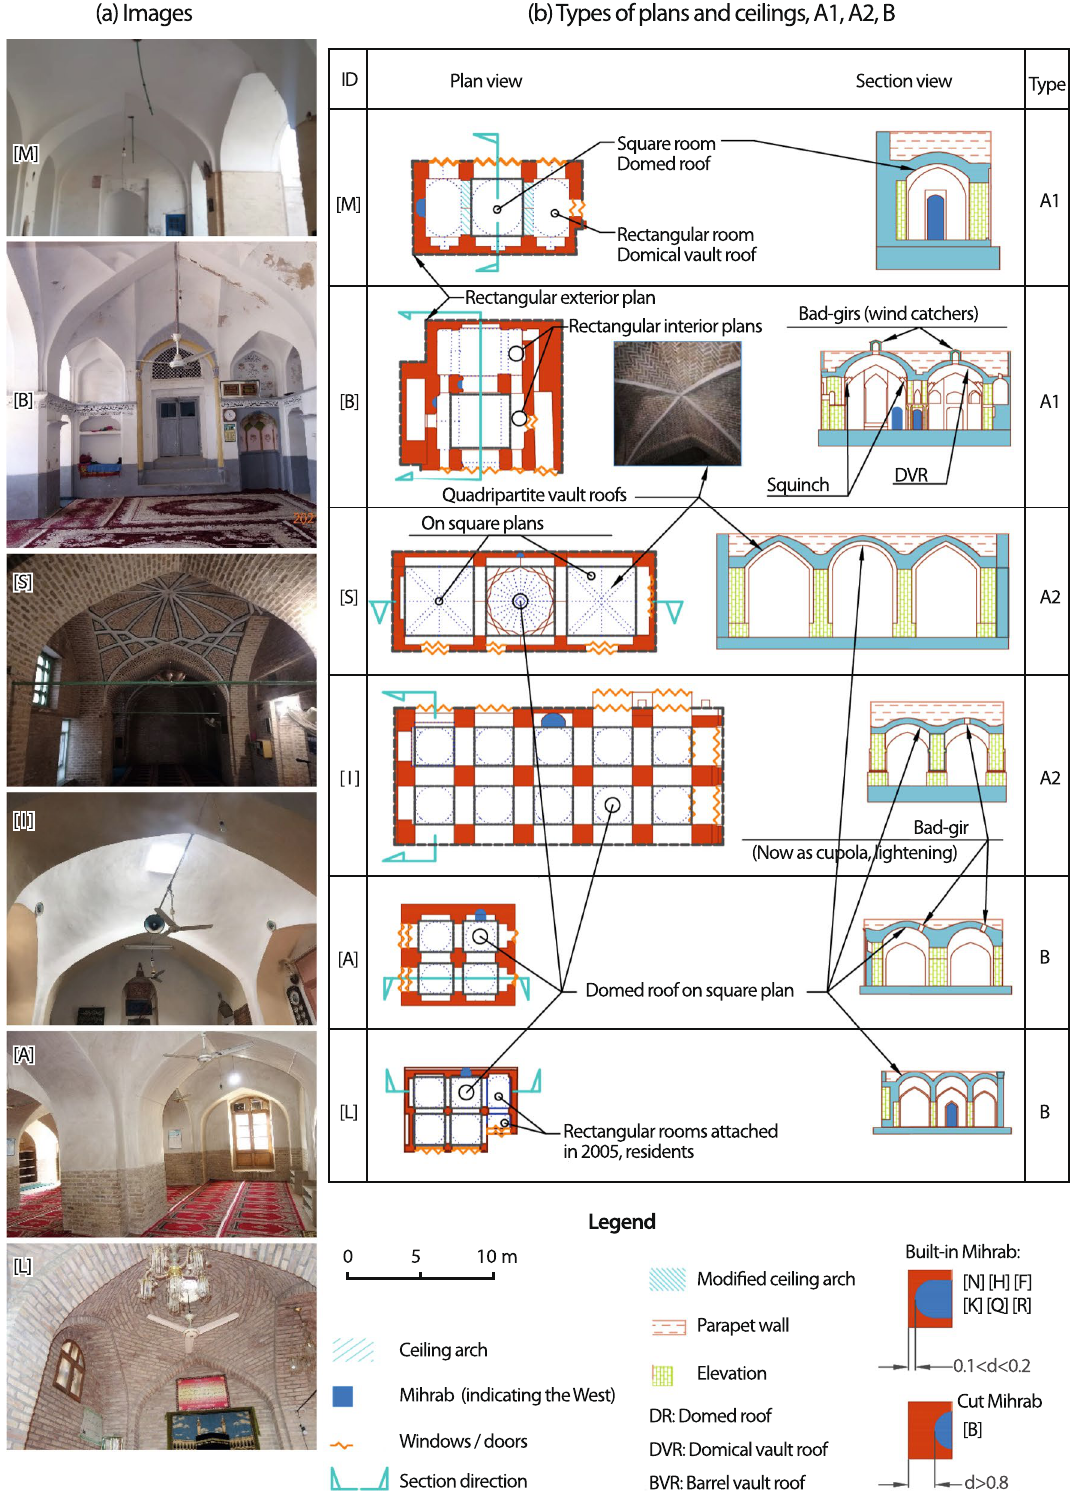
Fig. 5 Architectural classification of mosques, Types A1, A2, B. 2021 (Source: the